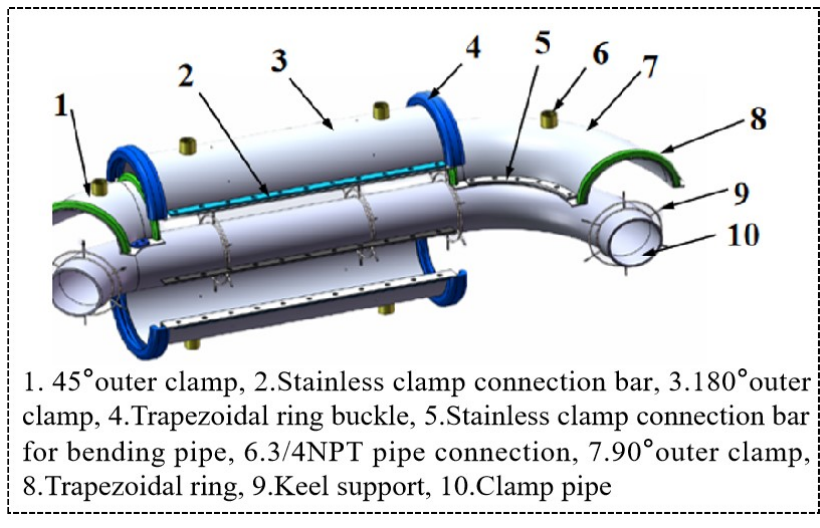
Figure 1. The external clamp’s structure and components.